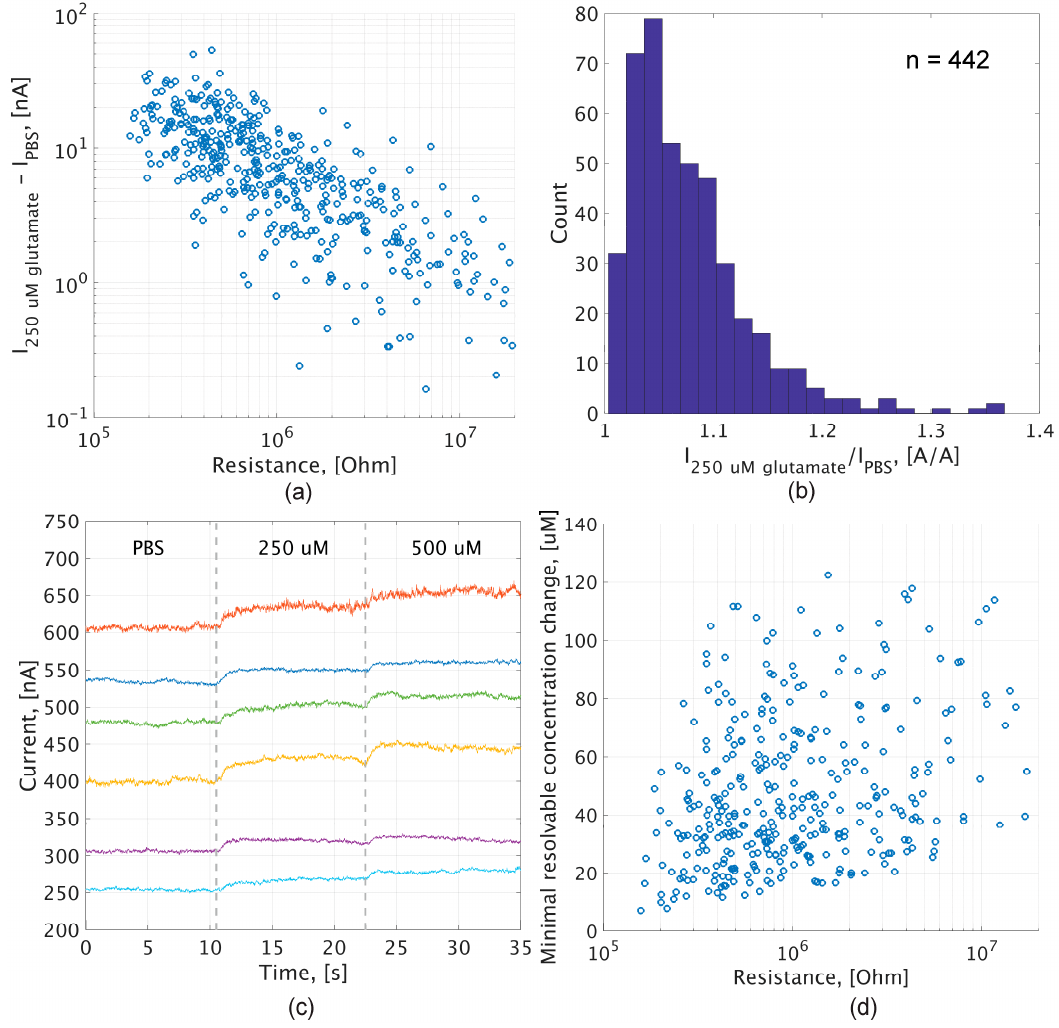
Figure 8. ( a ) Scatter plot of the absolute changes of the CNTFET currents, ∆ I= I 250µM _glutamate -I PBS versus the respective initial resistance values, R PBS ; ( b ) Histogram of the respective relative current changes of 442 CNTFETs of the array; ( c ) Amperometric curves versus time of 6 different individual CNTFET devices upon applying glutamate solution of two different concentrations; ( d ) Scatter plot of the minimal resolvable values of glutamate concentration changes versus the respective initial resistance values, R PBS .